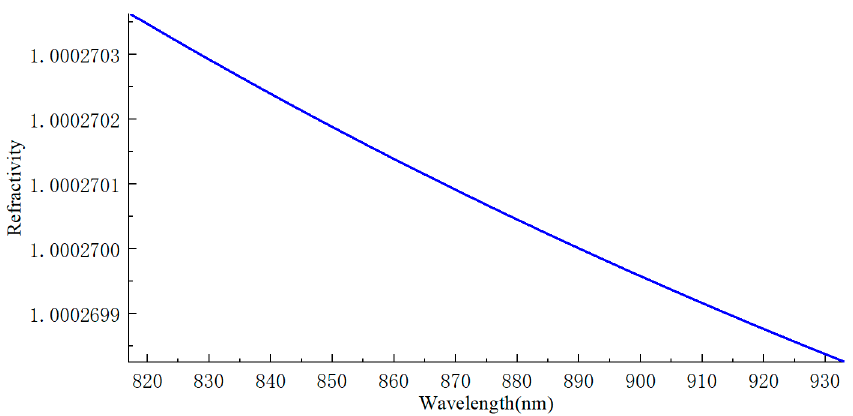
Table 2. The results collected multiple times at the same location. Figure 6. The air refractivity–wavelength relationship curve at 773.314 torrs (103.1 kPa) and 25 °C.